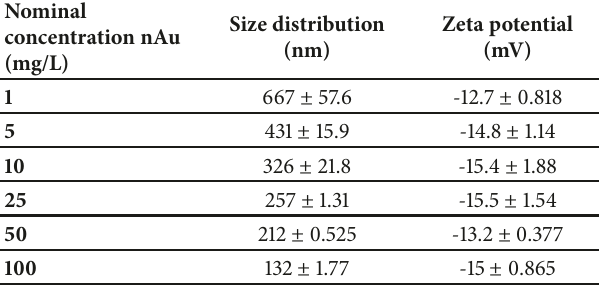
Table 2: Characterization of nAu in M9-media (mean ±